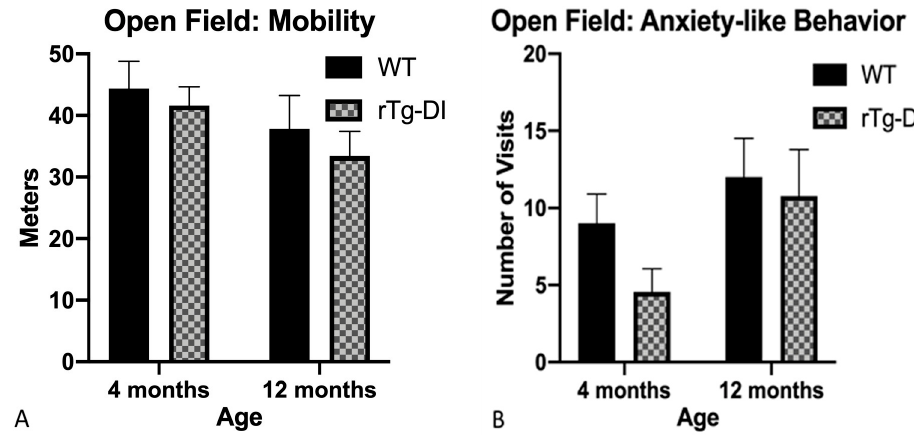
Figure 8. Exploration of the open field. ( A ) Mobility was measured by the average distance traveled and ( B ) anxiety-like behavior as measured by average number of entries to center region of the open field. Data represent mean +